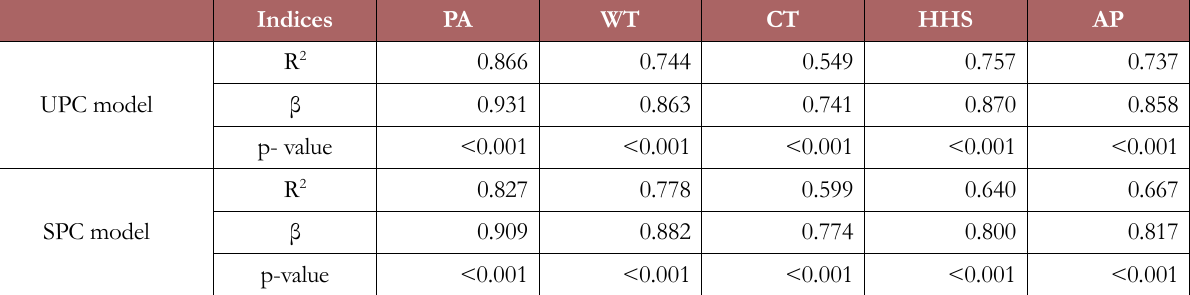
Table 7. HL Hierarchical model